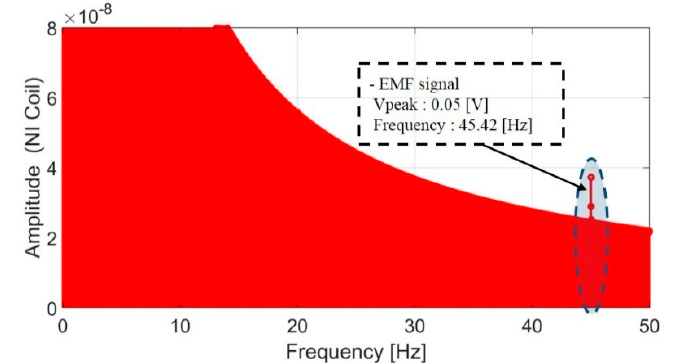
Appl. Sci. 2020 , 10 , x FOR PEER REVIEW Figure 7. FFT analysis results using the not-insulated (NI) coil. Figure 7. FFT analysis results using the not-insulated (NI) coil.